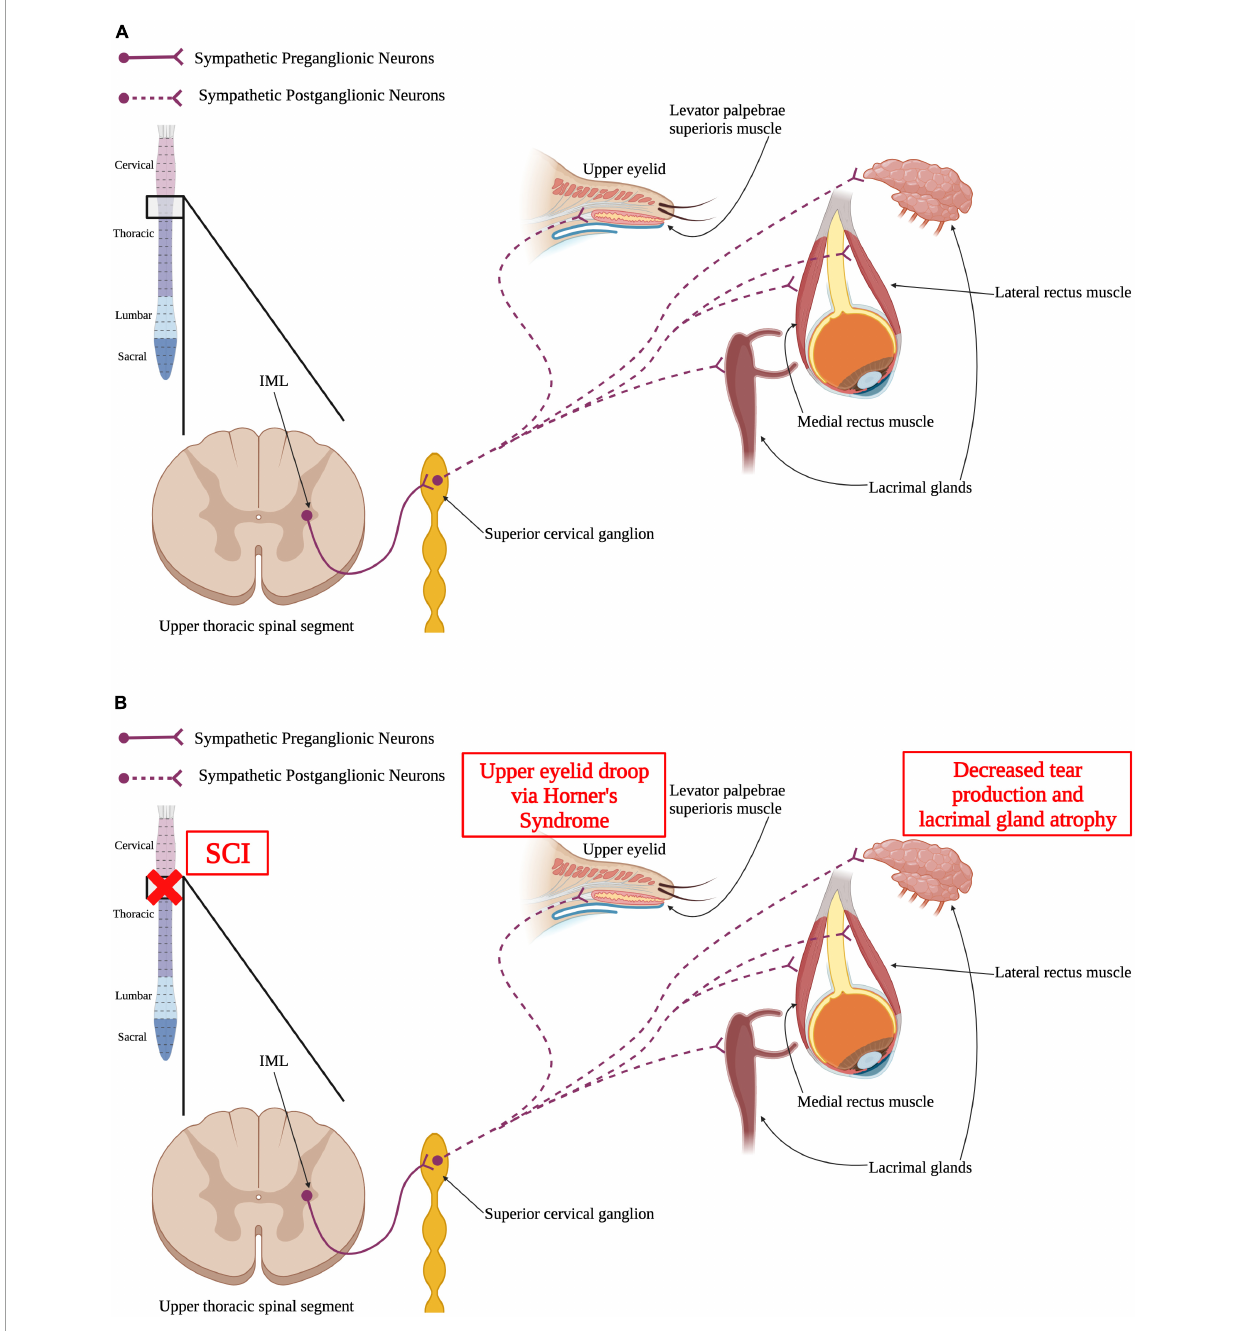
FIGURE4 Autonomic control of the visual system and how SCI impacts the visual system. (A) Sympathetic preganglionic neurons in upper thoracic spinal segments extend out of the spinal cord via the ventral horn to synapse upon sympathetic postganglionic neurons in the superior cervical ganglion. These neurons then directly innervate the levator palpebrae superioris muscle within the upper eyelid, the lacrimal glands, and the medial and lateral rectus muscles. (B) SCI may result in Horner’s syndrome where the upper eyelid begins to droop. Similarly, SCI may cause the lacrimal glands to have reduced tear production and atrophy that can ultimately result in dry eye. (Created using www.biorender.com).